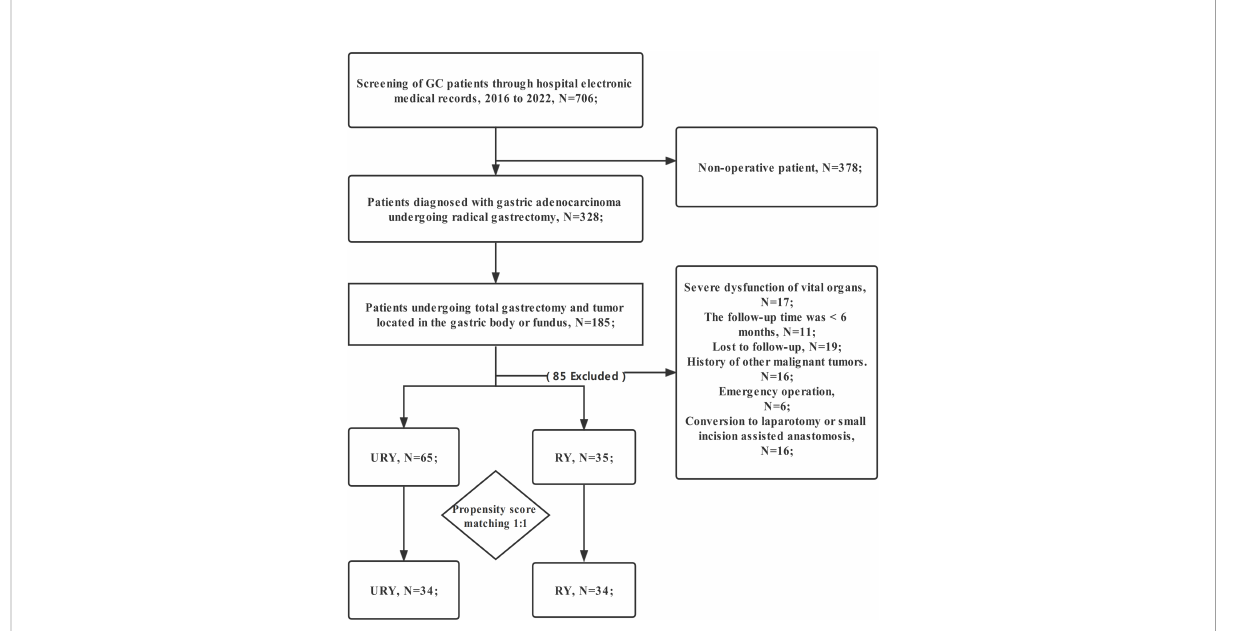
FIGURE 1 Flowchart of GC Patient Selection. GC, gastric cancer; RY, Roux-en-Y; URY, uncut